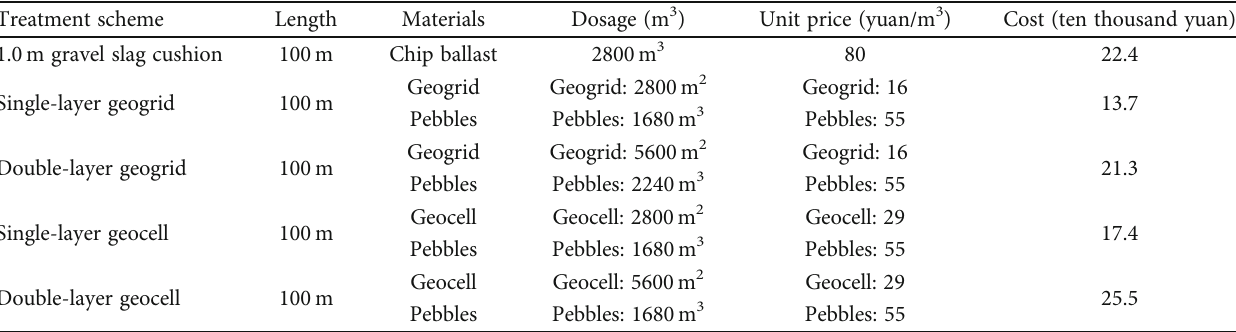
Table 4: Treatment plan economic bene fi t estimate